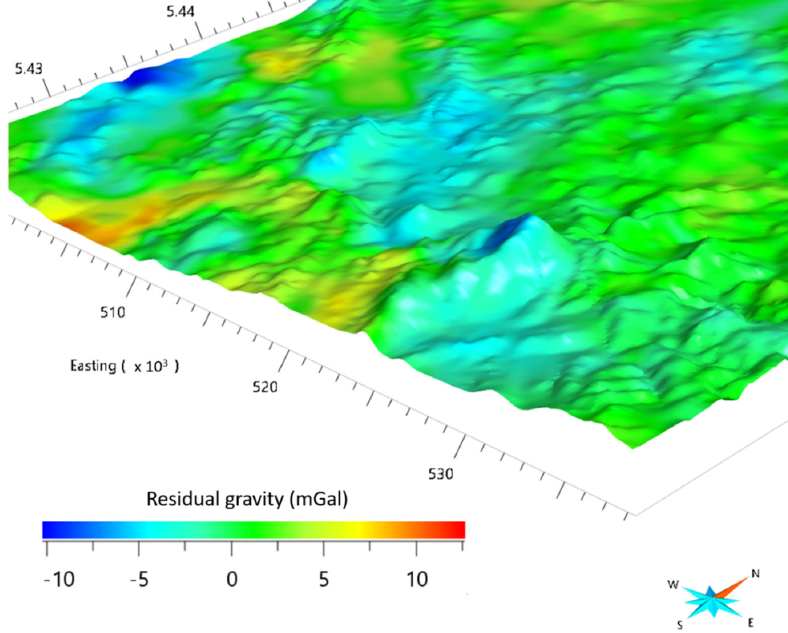
Figure 21. Gravity map draped over DEM. Note that gravity lows coincide with topographic highs resulting from inadequate terrain correction [39].